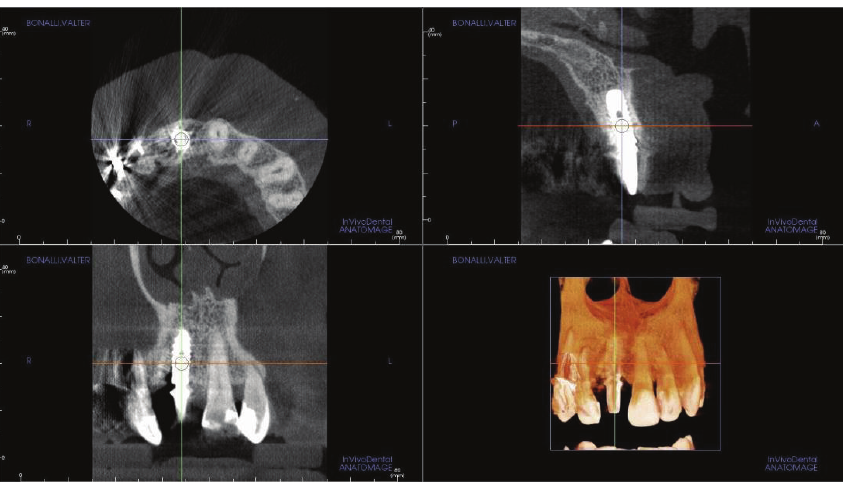
Figure 24: A third small FOV CBCT with 3D reconstruction confirmed excellent osseointegration of the implant with unchanged peri- implant marginal bone levels, indicating that the treatment proposed was able to restore the functional and aesthetic parameters.